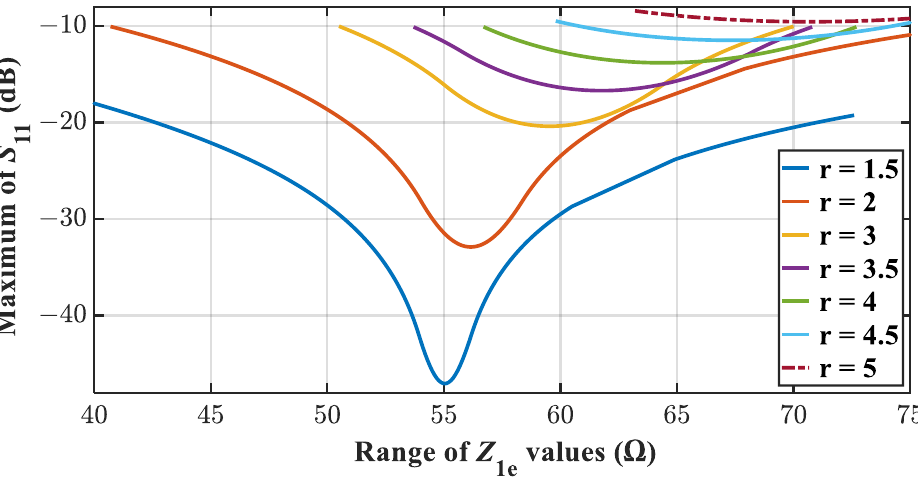
Figure 6. Variation of Maxima values of | S 11 ( f 1 < f < f 2 )| with Z 1 e.